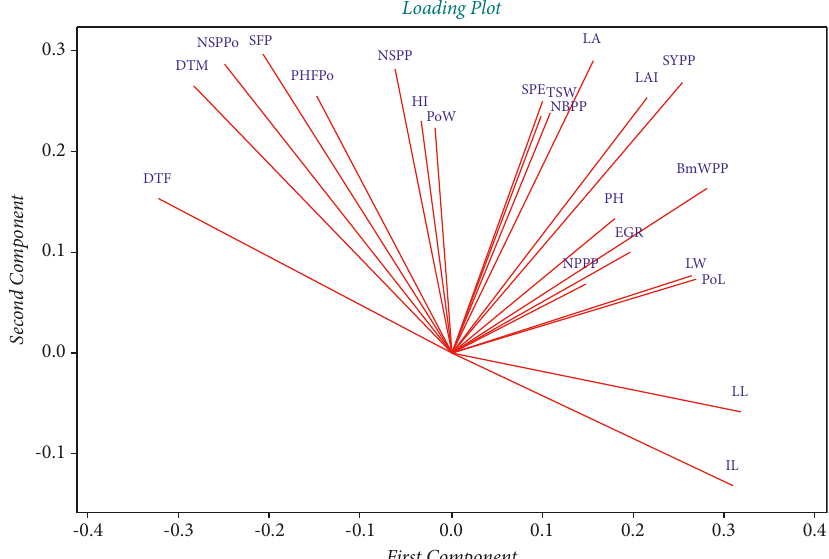
Figure 1: PCA loading plot showing the extents and direction of association among the 22 quantitative traits used in the present study.